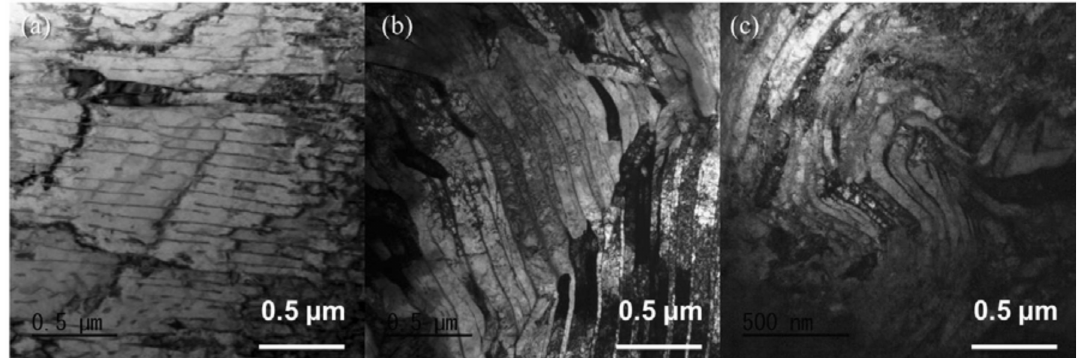
Figure 4. TEM images ( a ) before and after cold swaging of specimens, corresponding to area reduction ratios of ( b ) 50% and ( c ) 84%.